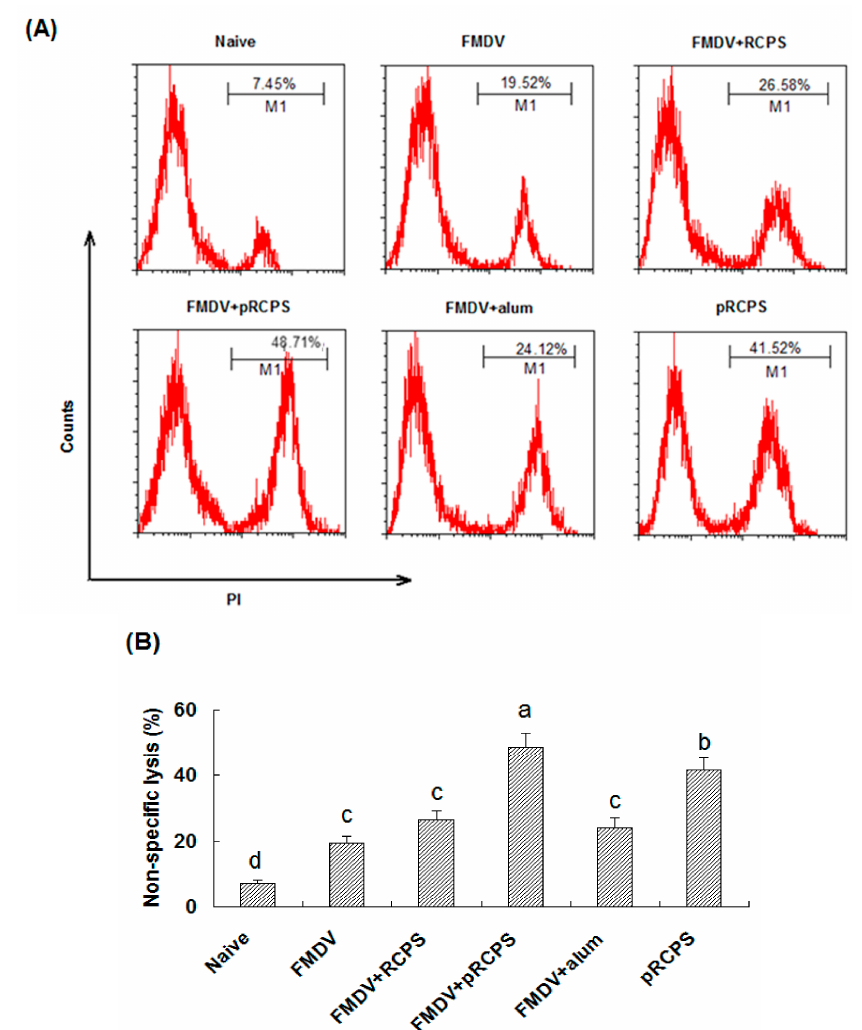
Figure 5. Effects of pRCPS as an adjuvant on the activity of NK cells. In order to evaluate the effect of pRCPS on the killing activity of NK cells in vitro, K562 cells labeled with CFSE served as target cells while splenocytes prepared from FMDV-immunized ICR mice in all groups were used as effector cells. After killing 4 h, the PI was added to the reaction mixture. Then, the killing activity of NK cells was analyzed by FACS. The CFSE and PI double positive cells were selected and recorded, and the percentage of CFSE and PI double stained cells in total CFSE positive cells represent the non-specific lysis percentage. The percentage of non-specific lysis were showed in Figure 4A,B. The percentage lysis was determined for each group as described in Experimental Section. The different letters on a column differ significantly ( n = 10, p < 0.05).